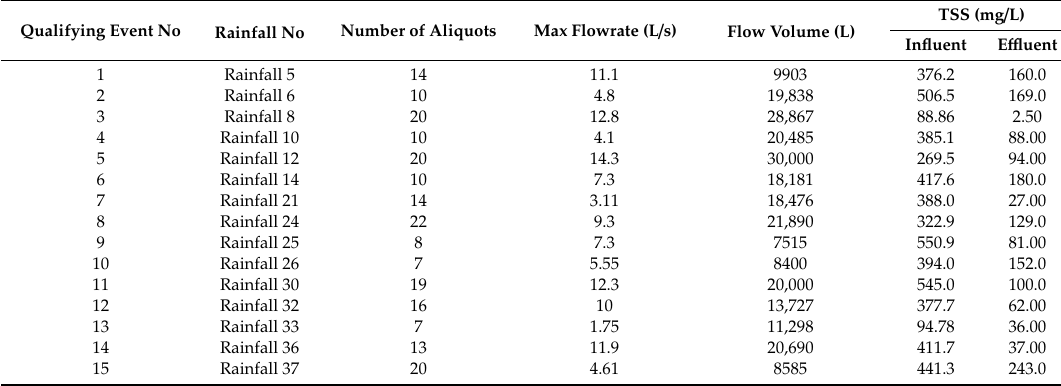
Table 2. Total suspended solids (TSS) influent and e ffl uent results ( LOD = 5 mg /